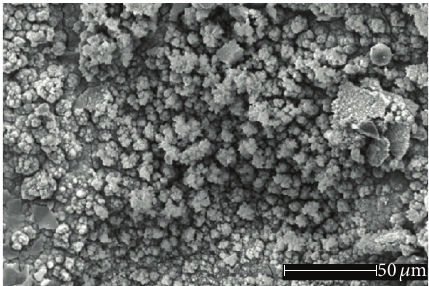
Figure 9: Micrograph showing sandy crystals typical of lepi-